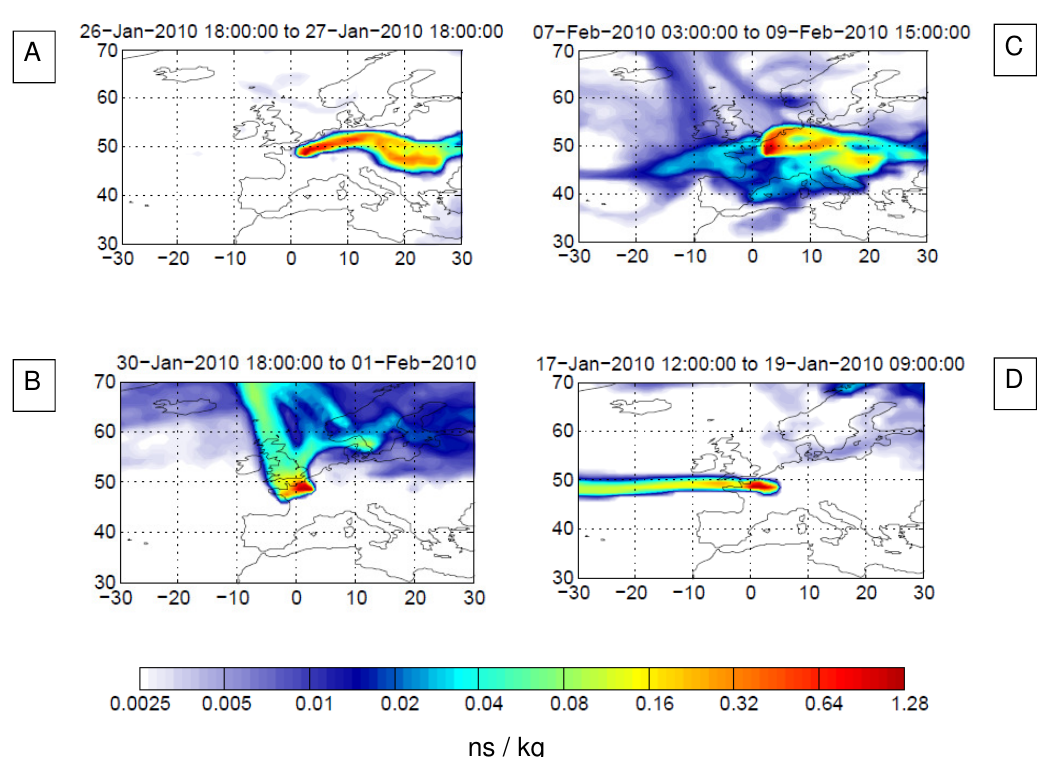
Fig. 5. Typical footprint potential emission sensitivities, from FLEXPART retroplume calculations. The X-axis represents the longitude while the Y-axis represents the latitude. Calculations are made for (A) and (C) the continental influence, (B) the biomass burning influence (SP2 coupled to HTDMA in this case), (D) the aged aerosol influenced air mass.